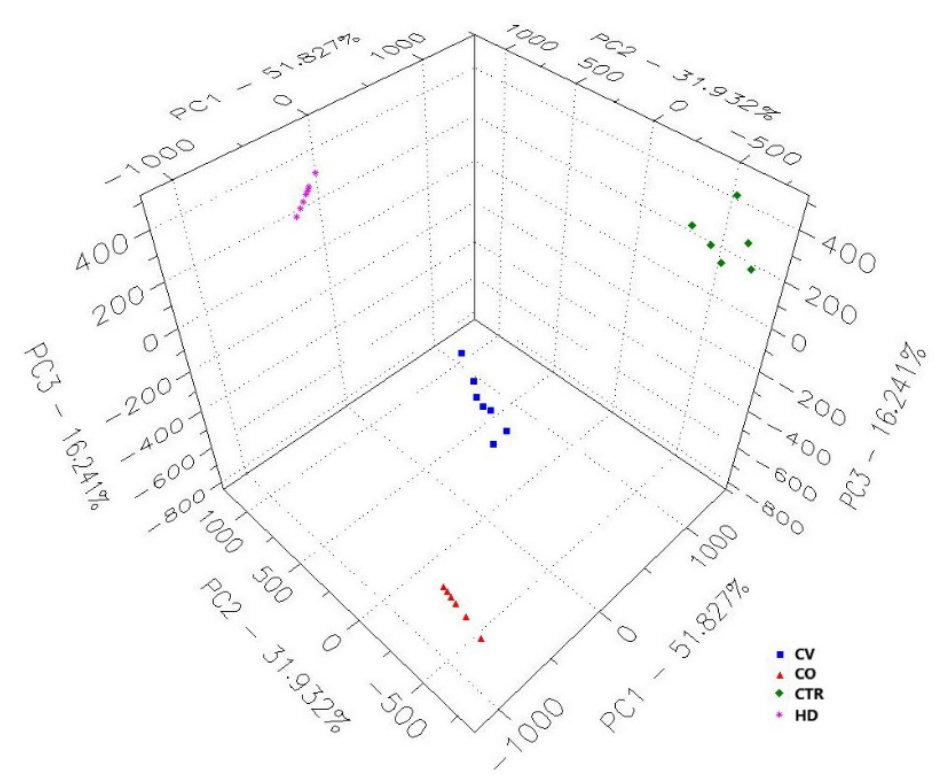
Figure 4. 3D-PCA representation based on the volatile profiles of the different red Topepo sweet peppers obtained by UFGC (CV: vegetable compost; CO: olive compost; CTR: control; HD: horse dung)